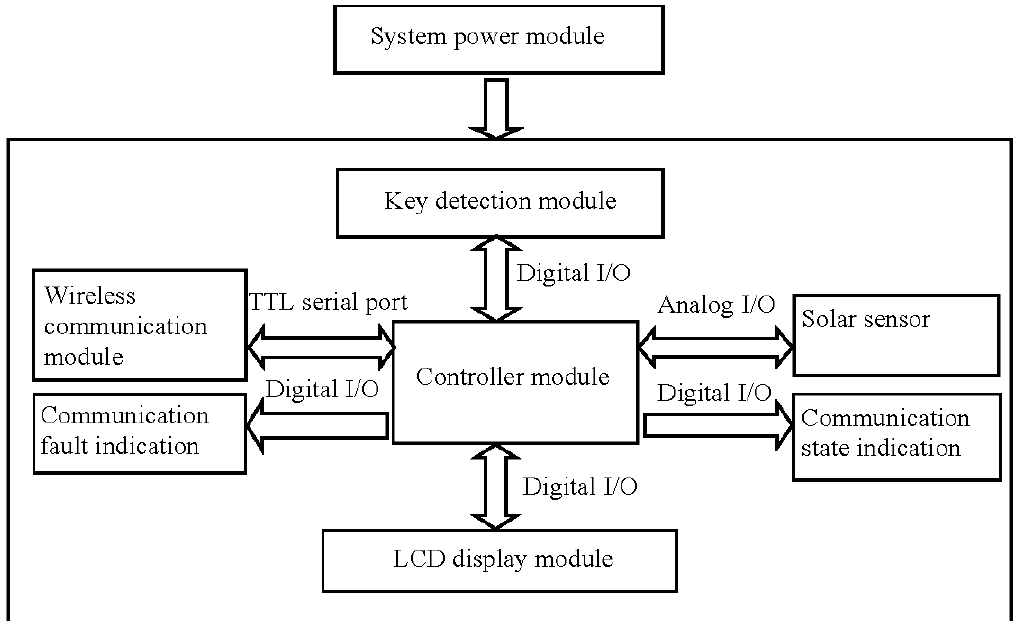
Figure 11. The overall connection structure of the hardware system.